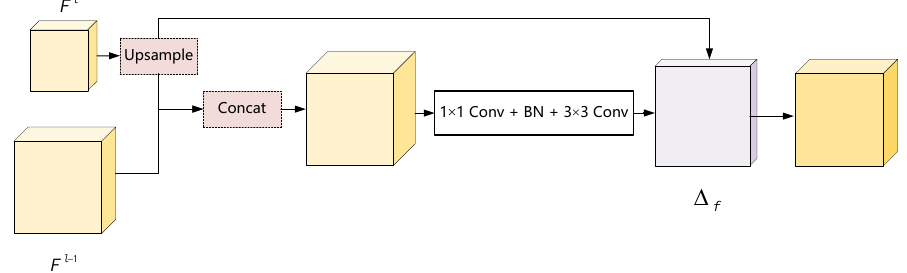
Figure 7. The framework of the proposed feature alignment module